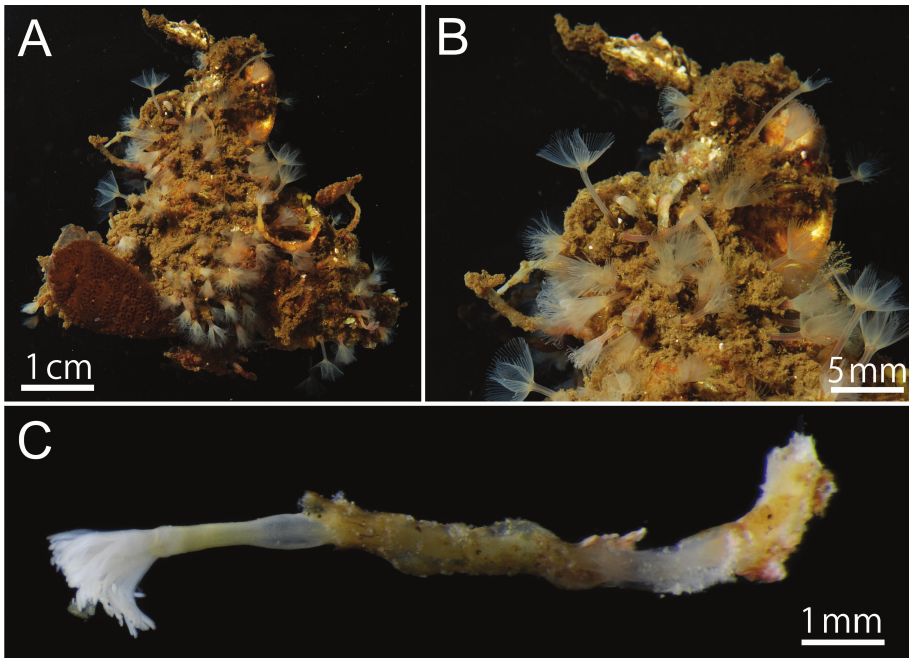
Figure 2. Phoronis ijimai Oka, 1897, NSMT-Te 879. A Living individuals collected from the pier of Misaki Marine Biological Station B enlargement of living individuals C preserved individual (10% for- malin seawater) with a transparent cylindrical tube.